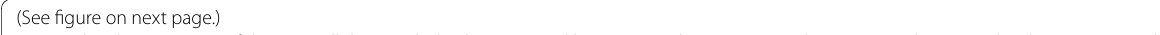
Fig. 2 The characteristics of the intracellular metabolic data. A partial least square discriminant analysis (PLS‑DA) between the sh‑NC group and sh‑FoxO3a group. B The student t‑test analysis showed that 25 metabolites differed between the sh‑NC and knockdown groups. C The area under the receiver operating characteristic (ROC) curve for intracellular metabolites. There were 12 metabolites under the ROC curve greater than 90%, mainly amino acids and long‑chain unsaturated fatty acids. D The R package of PAPi. Only statistically significant differences in metabolites and low false discovery rate ( P < 0.05 by the Student’s t ‑test)